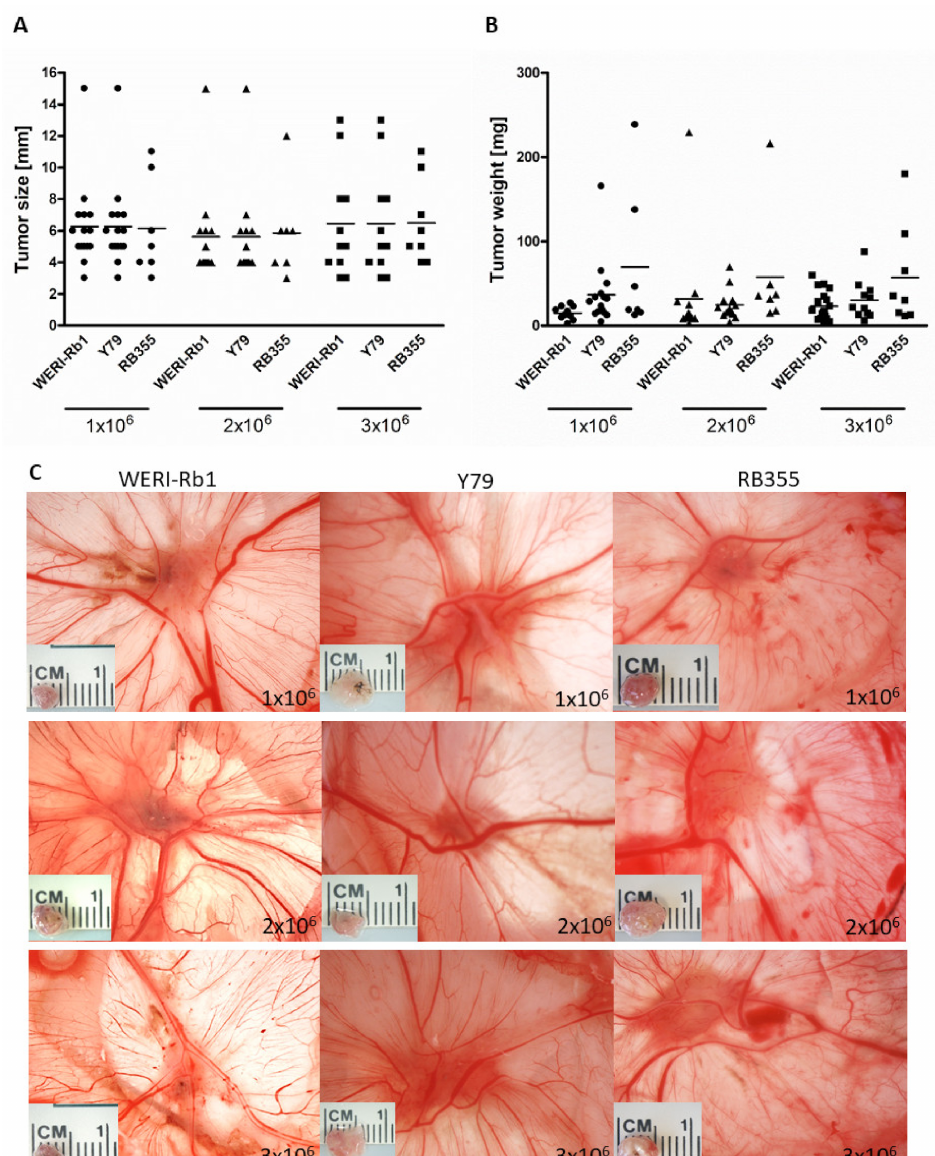
Figure 6. Effects of different RB cell concentrations on tumor size and weight in ovo . Tumor size ( A , C ) and weight ( B ) of all three RB cell lines (WERI-Rb1, Y79 and RB355) are not significantly influenced by different cell concentrations (1, 2 or 3 × 10 6 cells) inoculated on embryonic day (EDD10). Values are means of three independent experiments ± SEM. The symbols in ( A ) and ( B ) represent individual eggs used for grafting the following RB cell concentrations: circles: 1 × 10 6 cells, triangles: 2 × 10 6 cells, squares: 3 × 10 6